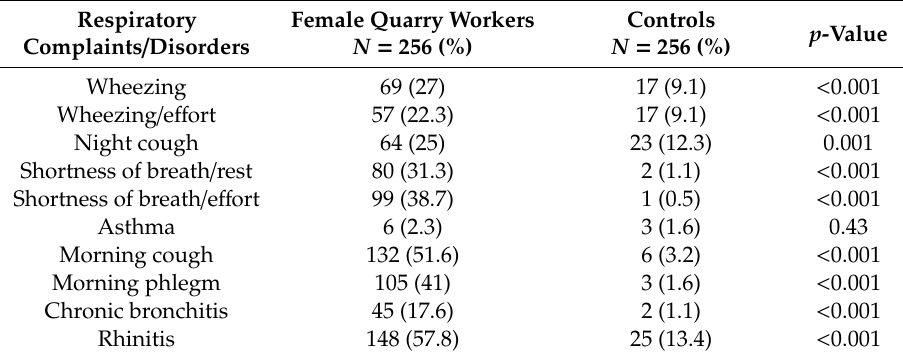
Table 2. Prevalence of respiratory manifestations in quarry workers and